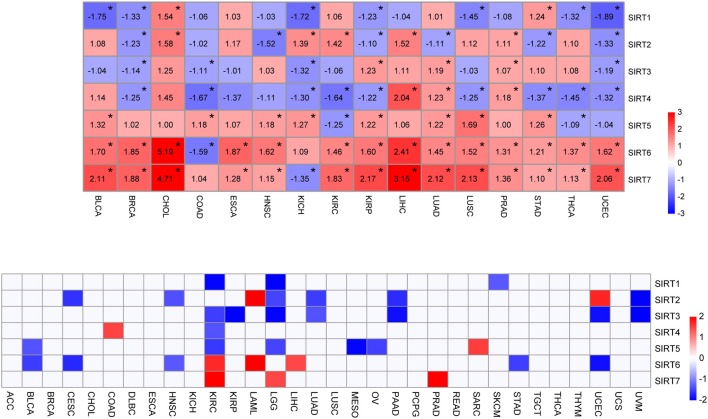
Expression level and survival analysis of sirtuins across TCGA cancer types. (A) Heatmap of sirtuins with changed expressions in 16 cancer cohorts compared to normal tissues (*P < 0.05). (B) Summary of hazard ratios (HR) illustrating cancer-sirtuin pairs with altered prognosis. ACC, Adrenocortical Carcinoma; BLCA, Bladder Urothelial Carcinoma; BRCA, Breast Invasive Carcinoma; CESC, Cervical Squamous Cell Carcinoma and Endocervical Adenocarcinoma; CHOL, Cholangiocarcinoma; COAD, Colon Adenocarcinoma; DLBC, Lymphoid Neoplasm Diffuse Large B-cell Lymphoma; ESCA, Esophageal Carcinoma; HNSC, Head and Neck Squamous Cell Carcinoma; KICH, Kidney Chromophobe; KIRC, Kidney Renal Clear Cell Carcinoma; KIRP, Kidney Renal Papillary Cell Carcinoma; LAML, Acute Myeloid Leukemia; LGG, Brain Lower Grade Glioma; LIHC, Liver Hepatocellular Carcinoma; LUAD, Lung Adenocarcinoma; LUSC, Lung Squamous Cell Carcinoma; MESO, Mesothelioma; OV, Ovarian Serous Cystadenocarcinoma; PAAD, Pancreatic Adenocarcinoma; PCPG, Pheochromocytoma and Paraganglioma; PRAD, Prostate Adenocarcinoma; READ, Rectum Adenocarcinoma; SARC, Sarcoma; SKCM, Skin Cutaneous Melanoma; STAD, Stomach Adenocarcinoma; TGCT, Testicular Germ Cell Tumors; THCA, Thyroid carcinoma; THYM, Thymoma; UCEC, Uterine Corpus Endometrial Carcinoma; UCS, Uterine Carcinosarcoma; UVM, Uveal Melanoma.